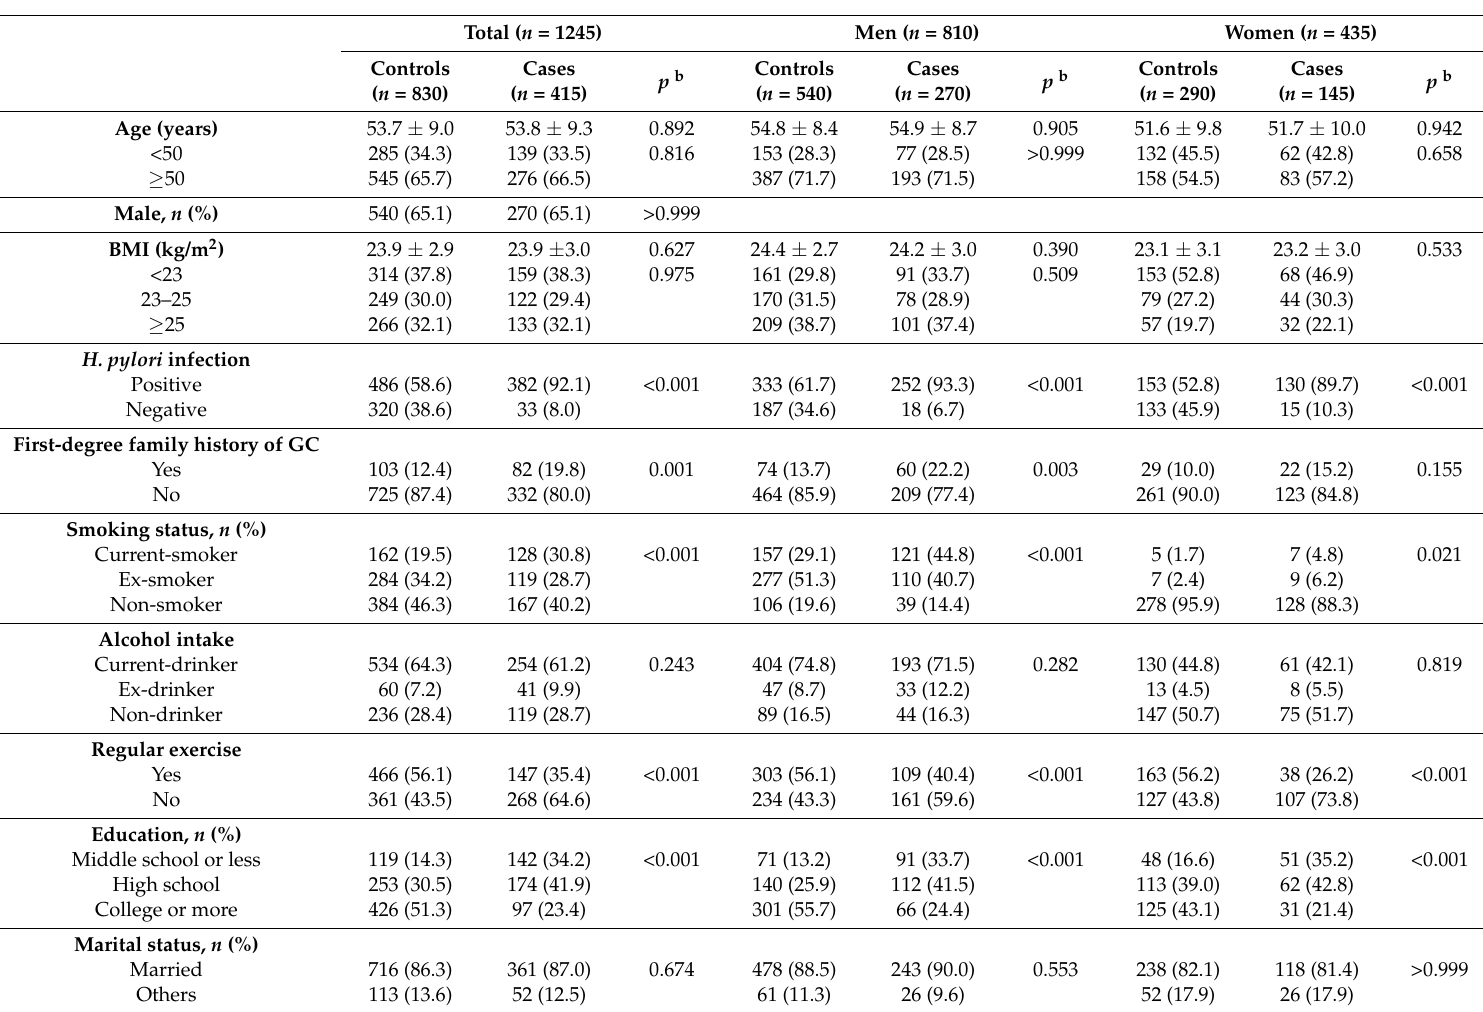
Table 1. General characteristics of the study subjects a